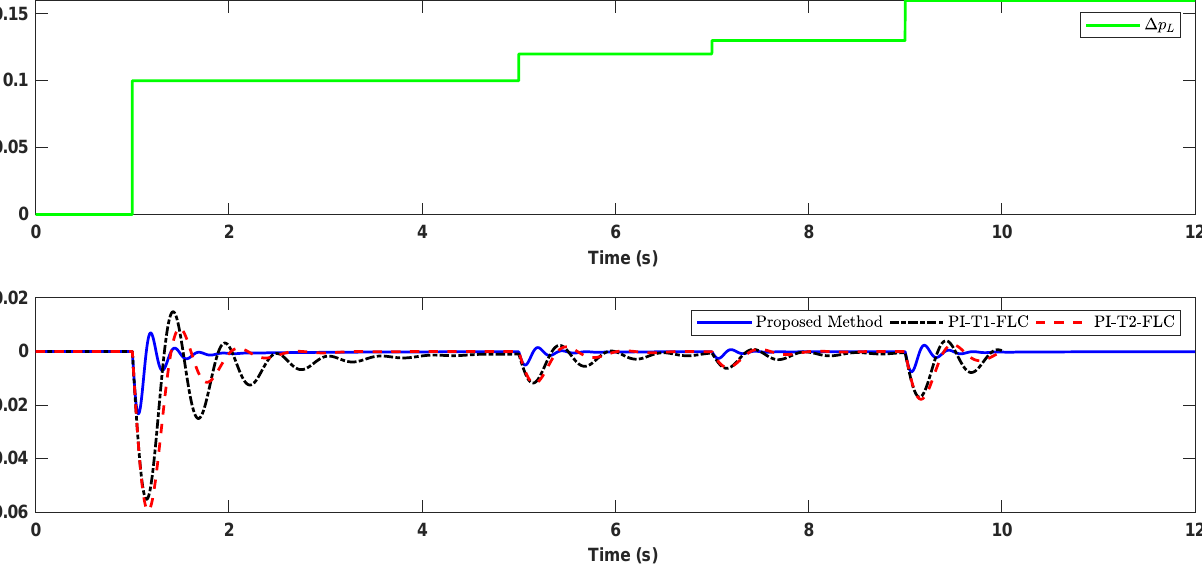
Figure 8. Example 1: Scenario 2: Frequency regulation performance in the presence of multiple load changes ( ∆ p L ). Scenario 3: In the third scenario, in addition to the multiple load changes, the value of parameters of all units are considered to time-varying. All parameters are changed as p = p ( 1 + sin ( t )) . The regulation performance is given in Figure 9. The well proficiency of the suggested LFC can be significantly seen form Figure